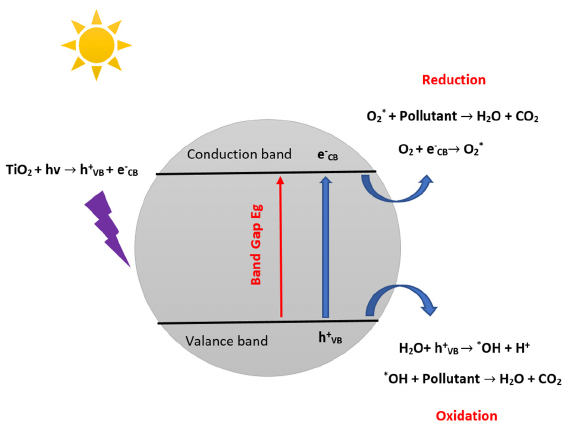
Figure 2. Schematic illustration of the photocatalytic reaction